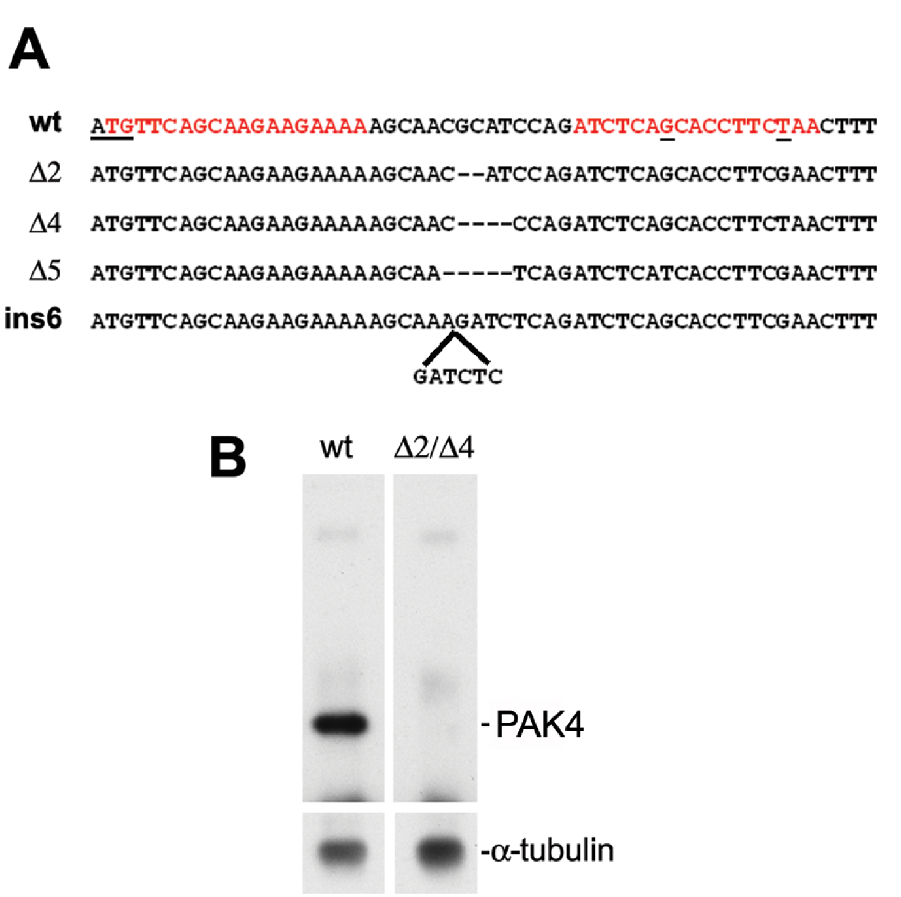
Figure 1. TALEN design and results of indel mutations in zebrafish pak4 . (A) Alignment of wild type pak4 sequence with mutated PCR amplicons. A pair of TALEN was designed overlapping (left arm) and downstream (right arm) the start ATG codon. The target sequences of the TAL Effector DNA-binding domains are highlighted in red. The start codon and two polymorphic nucleotides found within the right arm target are underlined. wt, wild type EK. D 2, D 4 and D 5, alleles with 2-, 4- and 5-nucleotide deletion, respectively. Ins6, allele with 6-nucleotide insertion. (B) Results of immunoblotting for pak4 protein. Total protein from 100 embryos at shield stage was collected, immunoprecipitated and analyzed using a custom-made zebrafish pak4 anti-peptide antibody. wt, wild type EK. D 2/ D 4, F 3 mutants of mixed genotypes pak4 D 2/ D 2, pak4 D 4/ D 4 and pak4 D 2/ D 4. pak4 protein with a predicted molecular weight of 72 kDa was detected in the wild type embryos but not in the mutants. Duplicate membrane probed with antibody to a -tubulin was used as loading control.